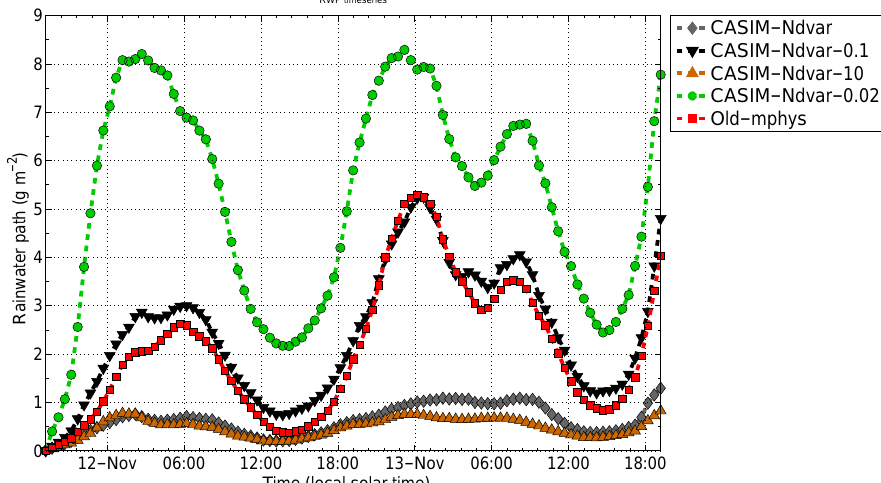
Figure 5. As for Fig. 4, except for RWP and for the models only.